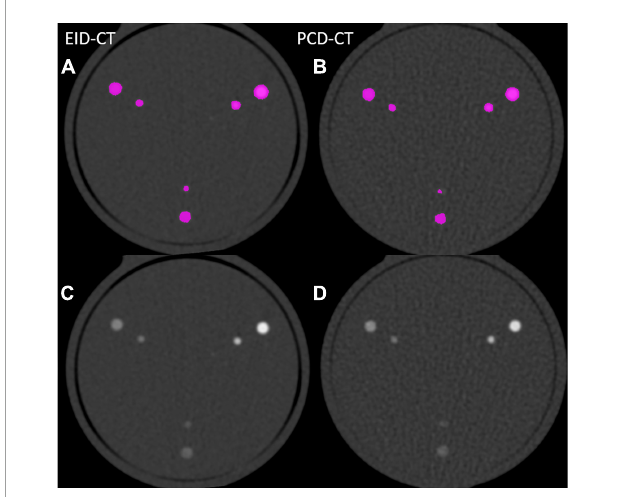
FIGURE1 Image examples from phantom scanned in the EID-CT (A,C) and PCD-CT (B,D) with and without color-overlay for